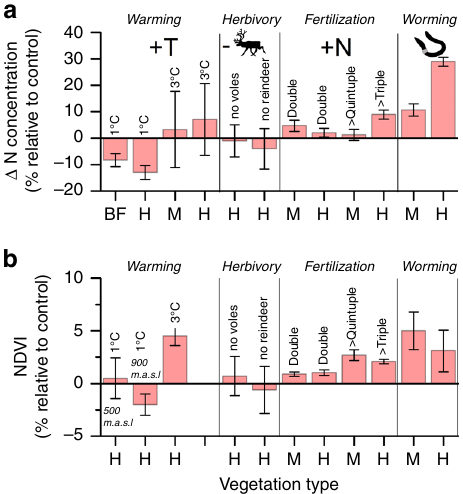
Fig. 6 Effects of earthworms compared to other environmental drivers in a changing Arctic. Shown are a conceptual comparison of effects (percentage change relative to average of control) caused by earthworms (worming) with effects seen in previous local experiments in sub-arctic northern Sweden simulating arctic environmental change including warming, herbivory, and fertilization. a Effects (mean ± std. err) on plant community N expressed as a function of vegetation type (BF = sub-arctic birch forest, H = heath, and M = meadow). Nitrogen data for warming are from open top chambers 35 and from an alpine altitudinal gradient 36 , the herbivory experiment was conducted using fences excluding voles and reindeer (shown effects are illustrating when grazers are present in relation to the ungrazed control) 35 and reindeer feces were used in the fertilization experiment, where additions corresponded to about double and four times natural abundance 37 . b Effects (mean ± std. err) on NDVI (i.e., greenness) expressed as a function of vegetation type. Experiments are similar as above with the addition of data from an open top chamber experiment simulating a mean annual temperature increase of 1 °C conducted at both an altitude of 500 and 900 m.a.s.l. Source data are provided in Supplementary Table 3, Supplementary Methods 1 and as a Source Data fi